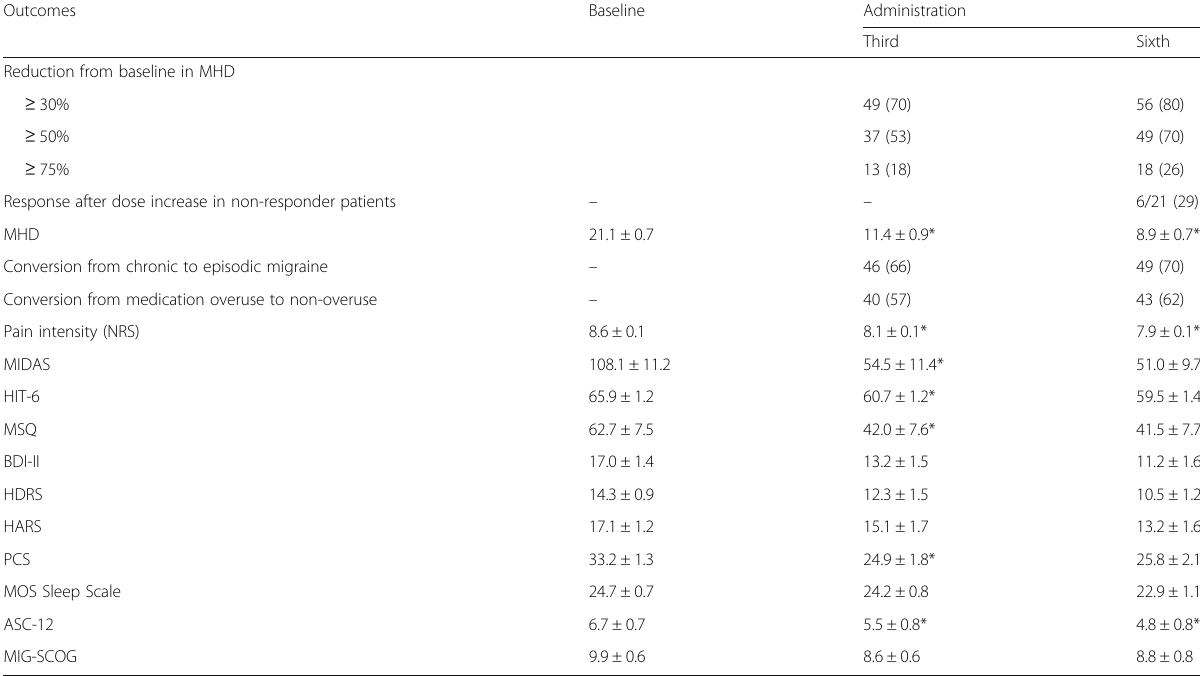
Table 3 Efficacy endpoints after the third and sixth monthly erenumab administrations ( n = 70) Outcomes Baseline